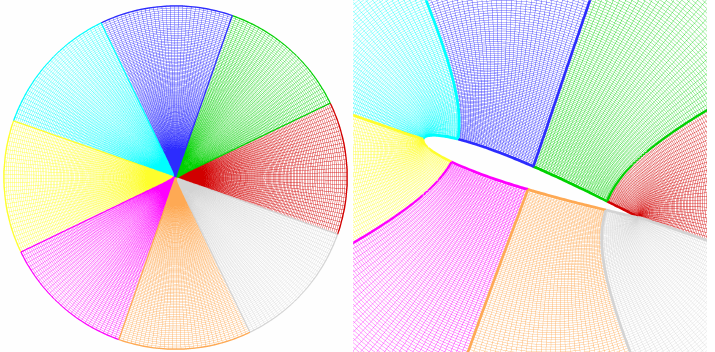
Figure 6. The computational domain partitioned in 8 parts; the different colors show the different parts of the domain to be assigned to different processing